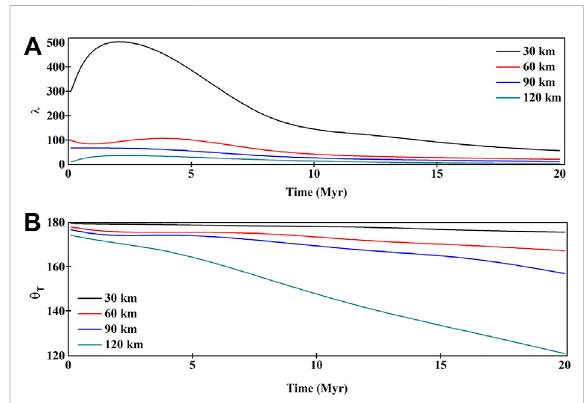
FIGURE 7 Time progression of (A) the shape factor ( λ ) and (B) the closing angle ( θ T ) of a trench in the simulation experiments for different MDD values (indicated in the graph